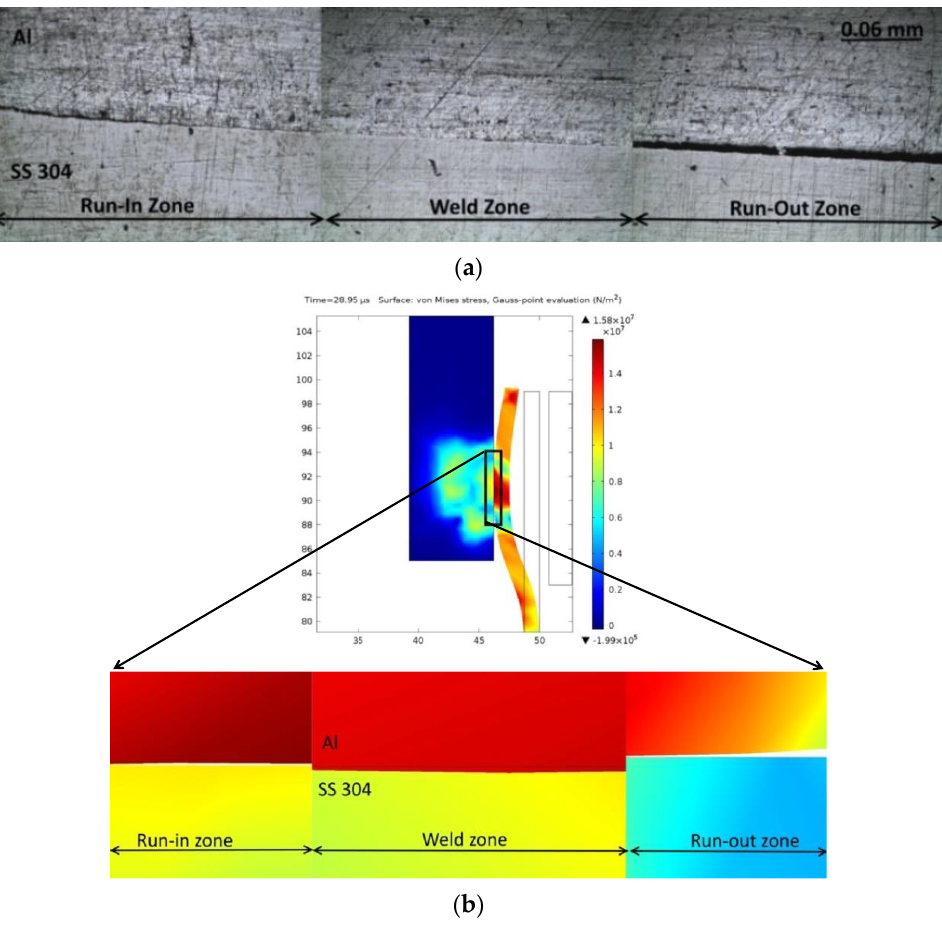
Figure 7. ( a ) Optical micrograph of a pulse-welded Al-SS304 member showing distinct zones at 10× magnification and ( b ) impact zone predicted by the FEM.